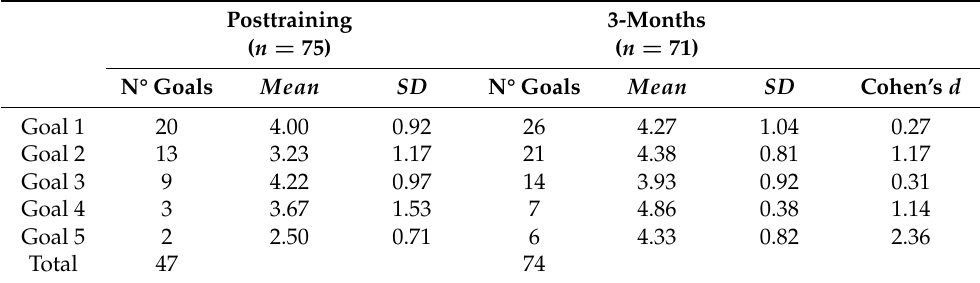
Table 2. Number and specificity of goals set at the posttraining and 3-month time